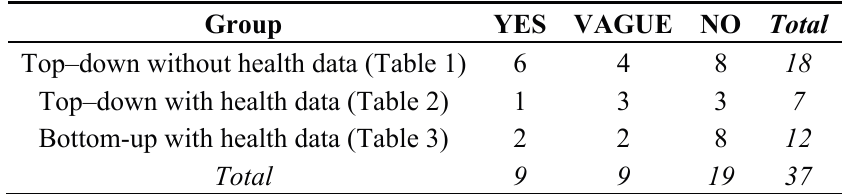
Table 4. Cooperation with decision makers, determined by the review of literature. Group YES VAGUE NO Total Top–down without health data (Table 1) 6 4 8 18 Top–down with health data (Table 2) 1 3 3 7 Bottom-up with health data (Table 3)